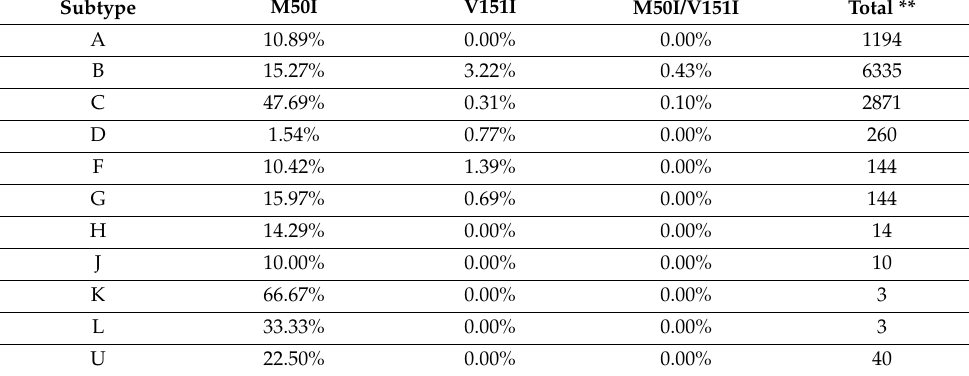
Table 3. Population diversity of M50I or V151I in the LANL HIV database *.